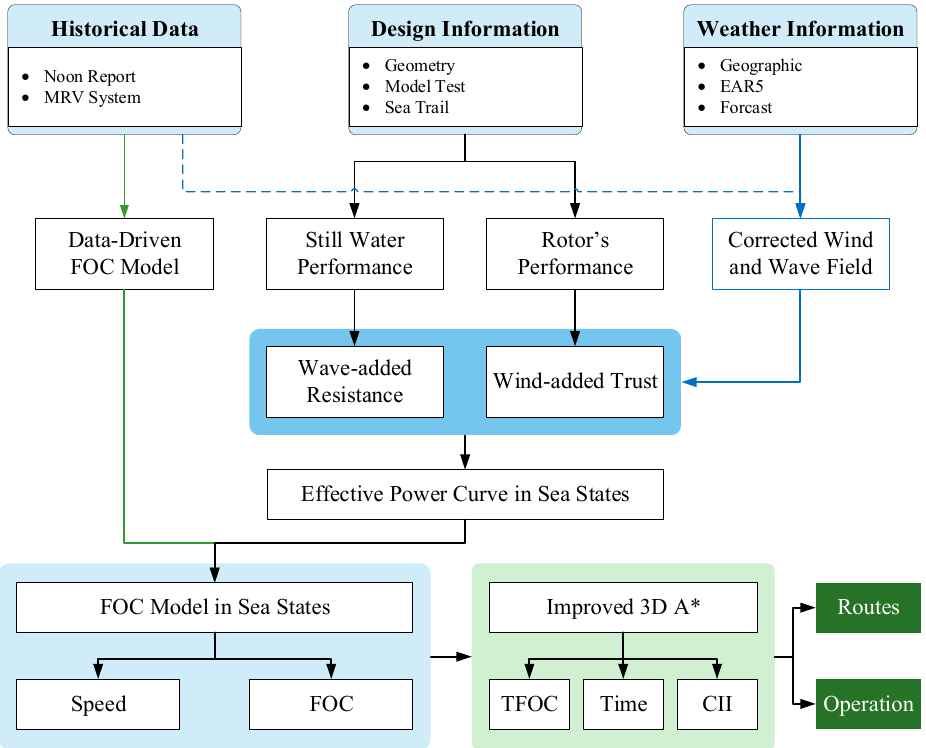
Figure 1. Scheme of the proposed weather-routing framework.